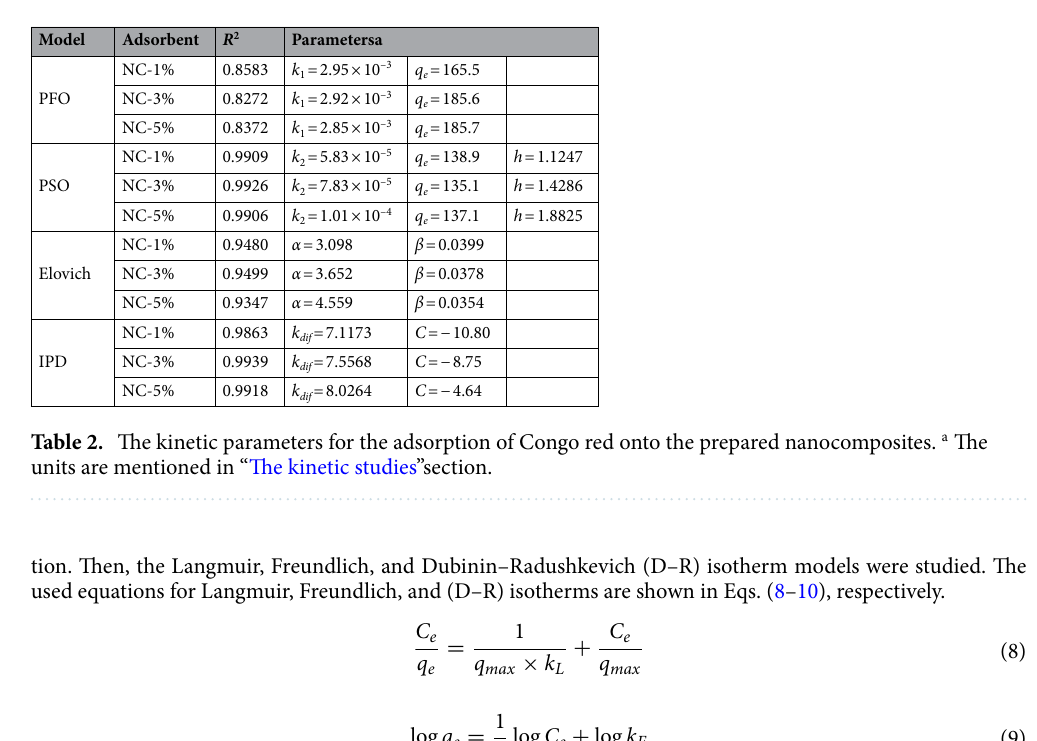
Figure 7. The pseudo-first-order ( a ), pseudo-second-order ( b ), Elovich ( c ), and intra-particle diffusion ( d ) adsorption models for the adsorption of CR.